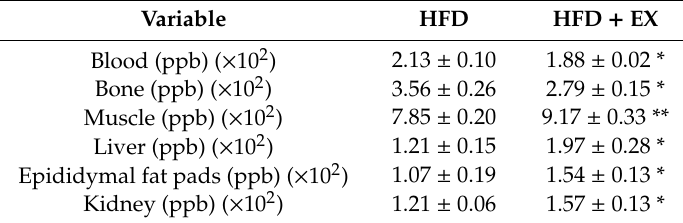
Table 1. E ff ects of exercise on levels of chromium in organs and tissues from control- or exercise-trained mice in a